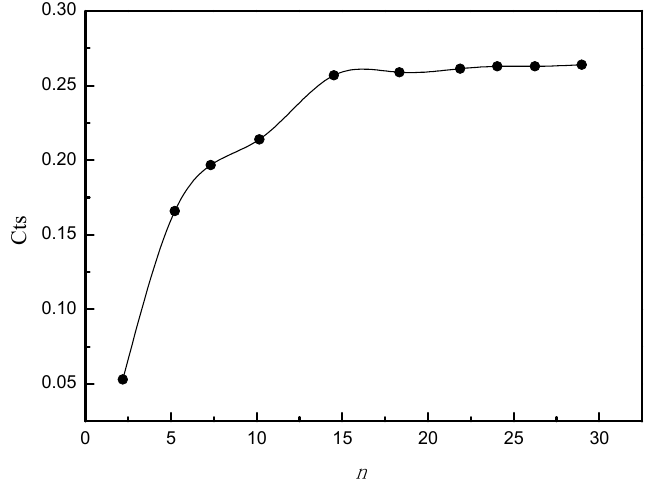
Figure 8. Static torque coefficient changed with the number of grids.